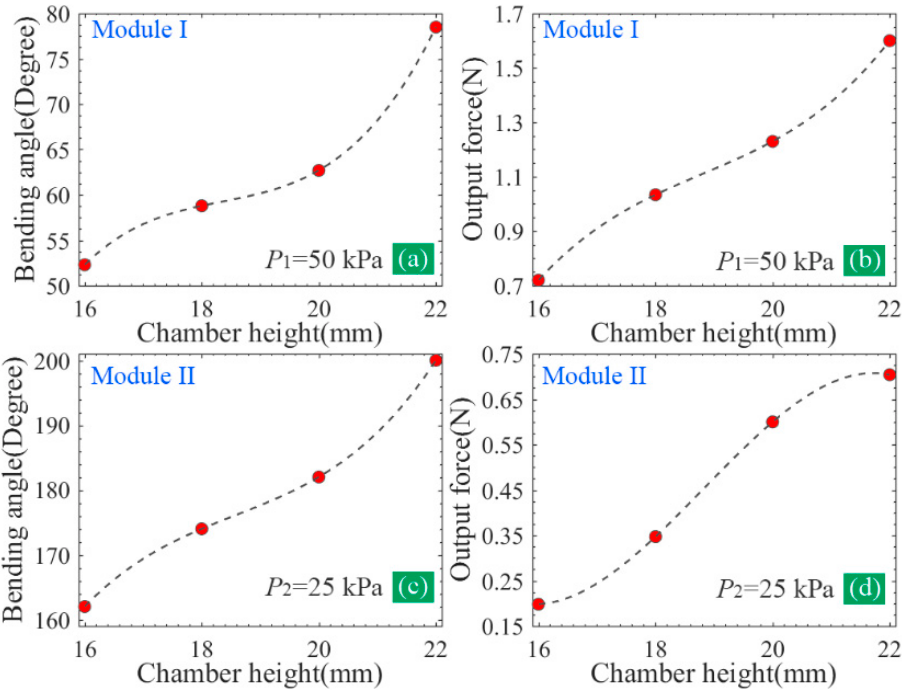
Figure 6. ( a , b ) The influence of the chamber height on the bending angle and tip force of module I, and ( c , d ) the influence of the chamber height on the bending angle and tip force of module II. Table 1. Parameters of the newly proposed soft pneumatic actuator.